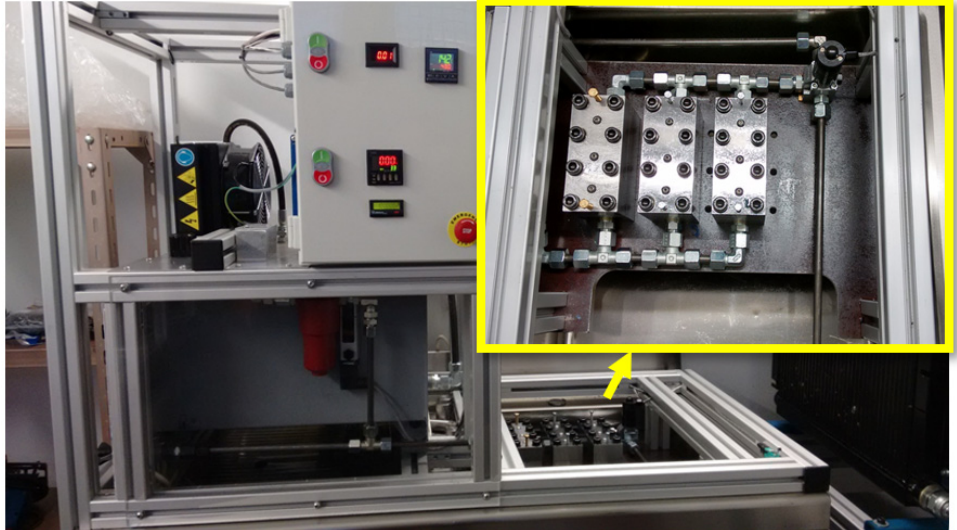
Figure 4. The pressure fatigue test rig.